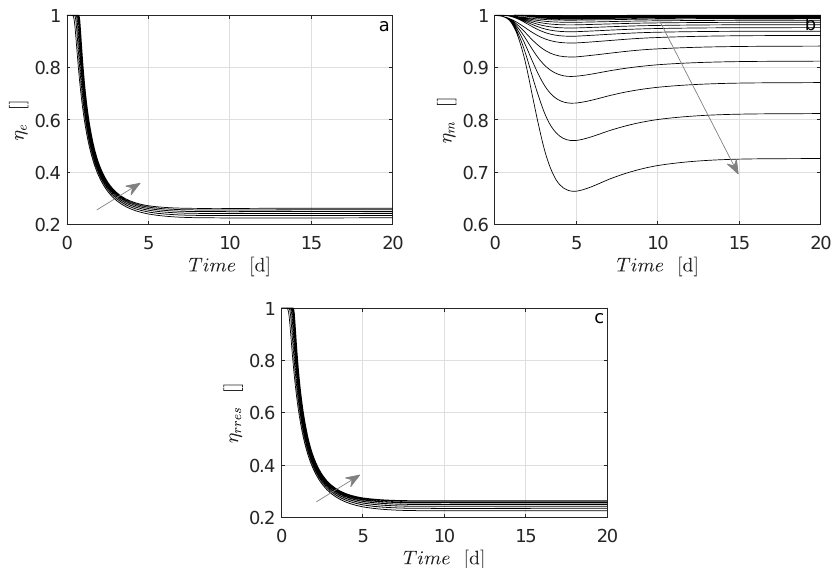
Figure 4. Numerical solution for the effectiveness factor for ( a ) exoelectrogenic microorganisms (Equation (15)), ( b ) methanogenic microorganisms (Equation (14)), and ( c ) respiration process (Equation (16)). Arrows indicate the direction of increased applied voltage.